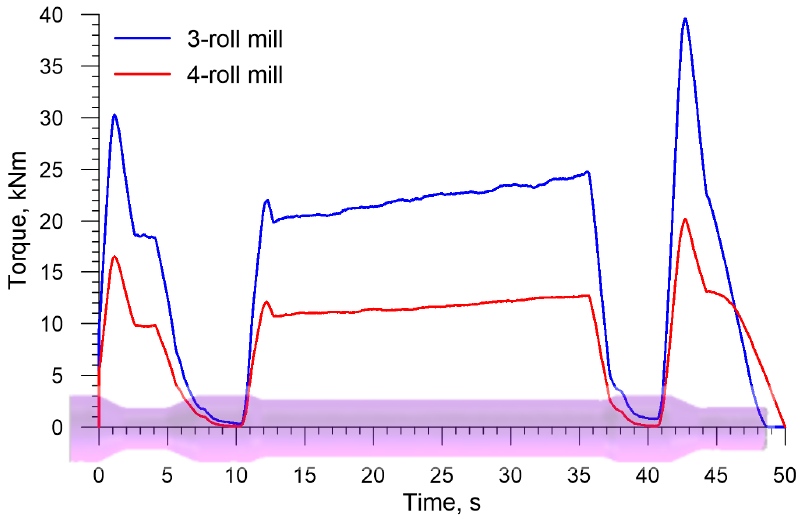
Figure 9. Torque on the roll in skew rolling axles in 3- and 4-roll mills.